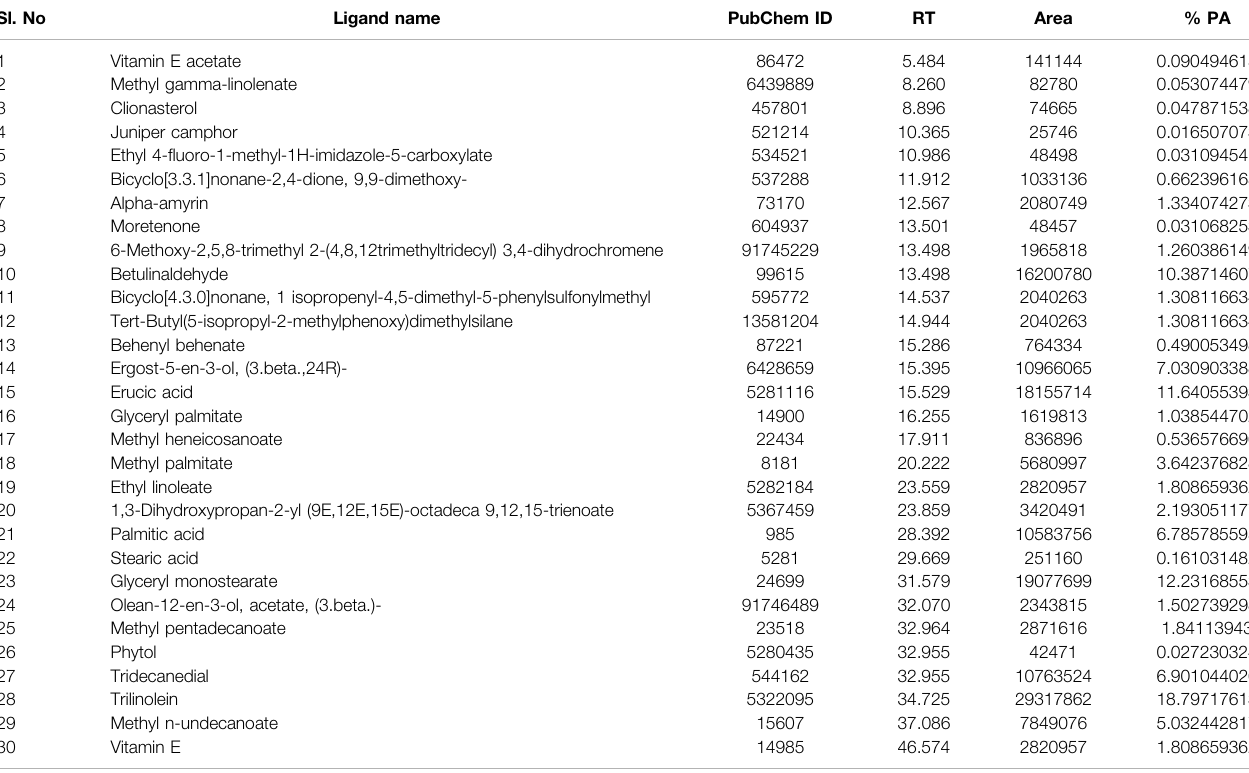
TABLE 1 | List of tentative compounds identi fi ed in a methanol extract of C. gigantea leaves by GC – MS analysis. Sl.